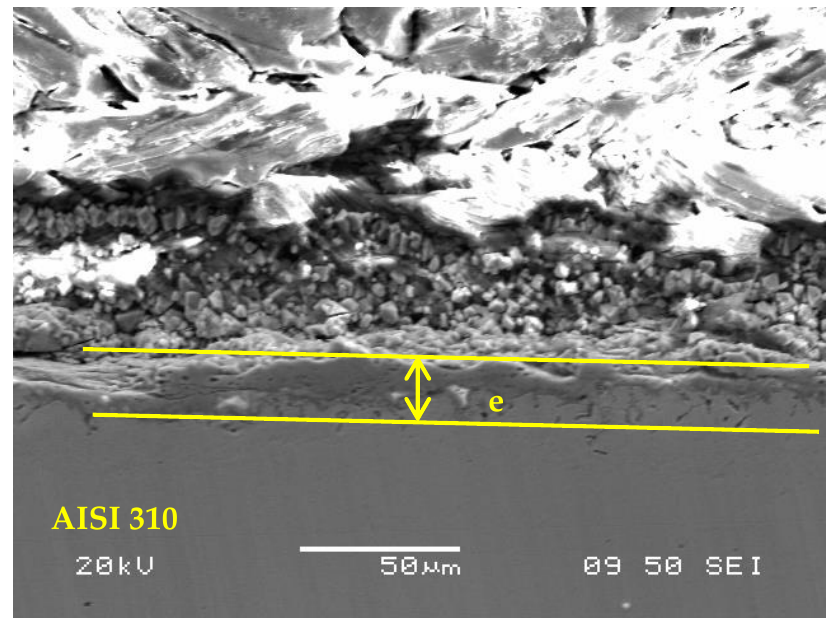
Figure 15. Oxide layer in AISI 304 sample.